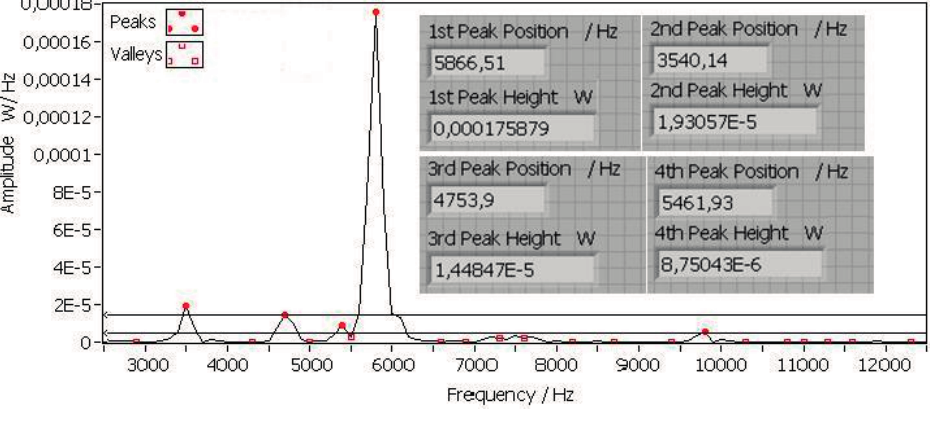
Figure 4. Feature extraction from PSD